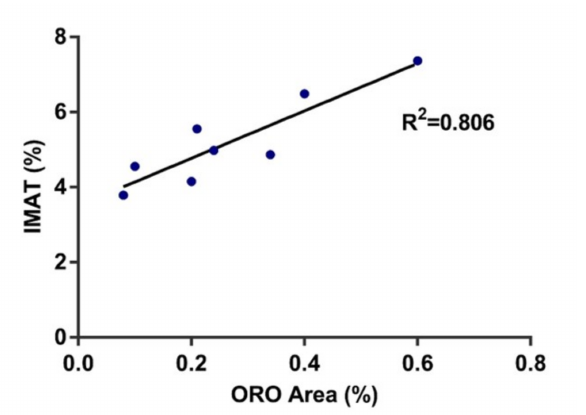
Figure 4. MicroCT fat-related parameter of IMAT% was highly correlated with ORO-positively